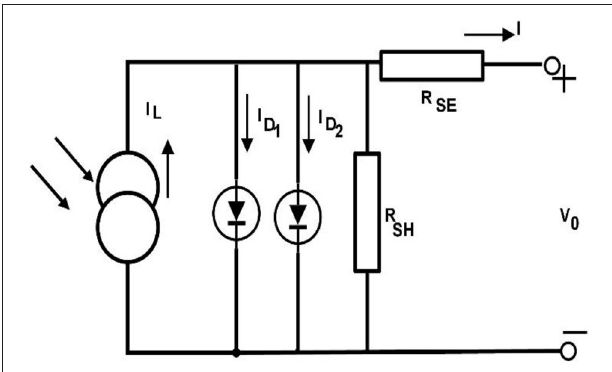
FIGURE 3 | Equivalent circuit model: two-diode photovoltaic (PV) model [2].